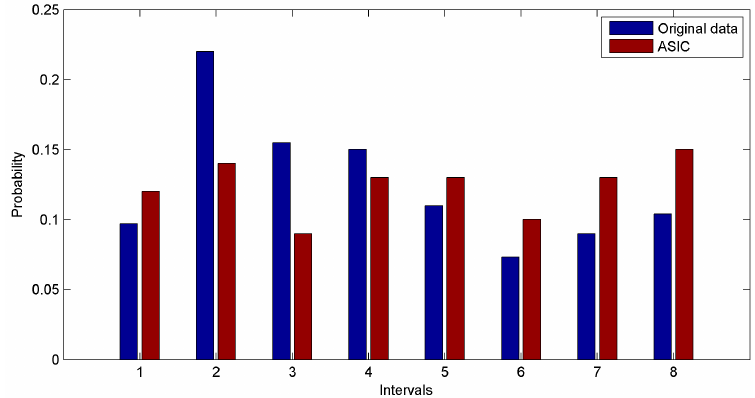
Figure 7. Comparison of distributions of data collected from real dataset.